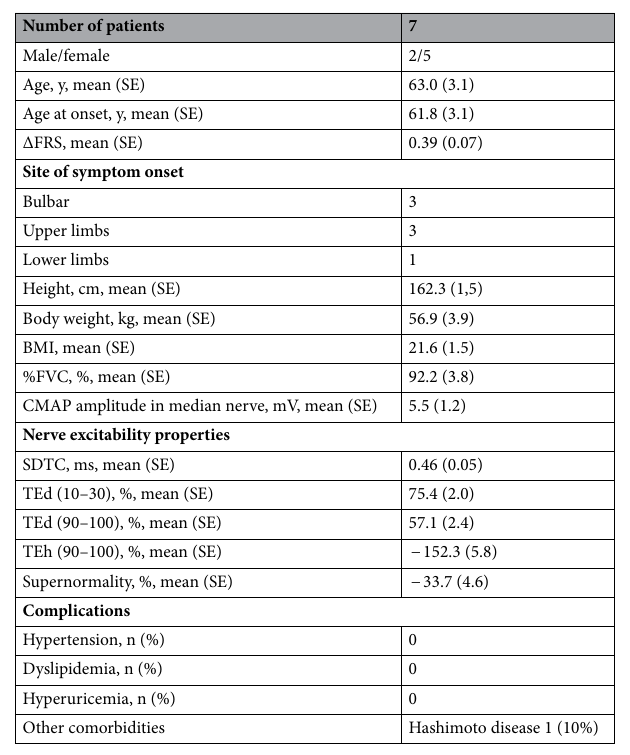
Table 2. Characteristic of the first amyotrophic lateral sclerosis group (n = 7). SE standard error, ΔFRS progression rate (ratio of Functional Rating Scale score to time), BMI body mass index, %FVC